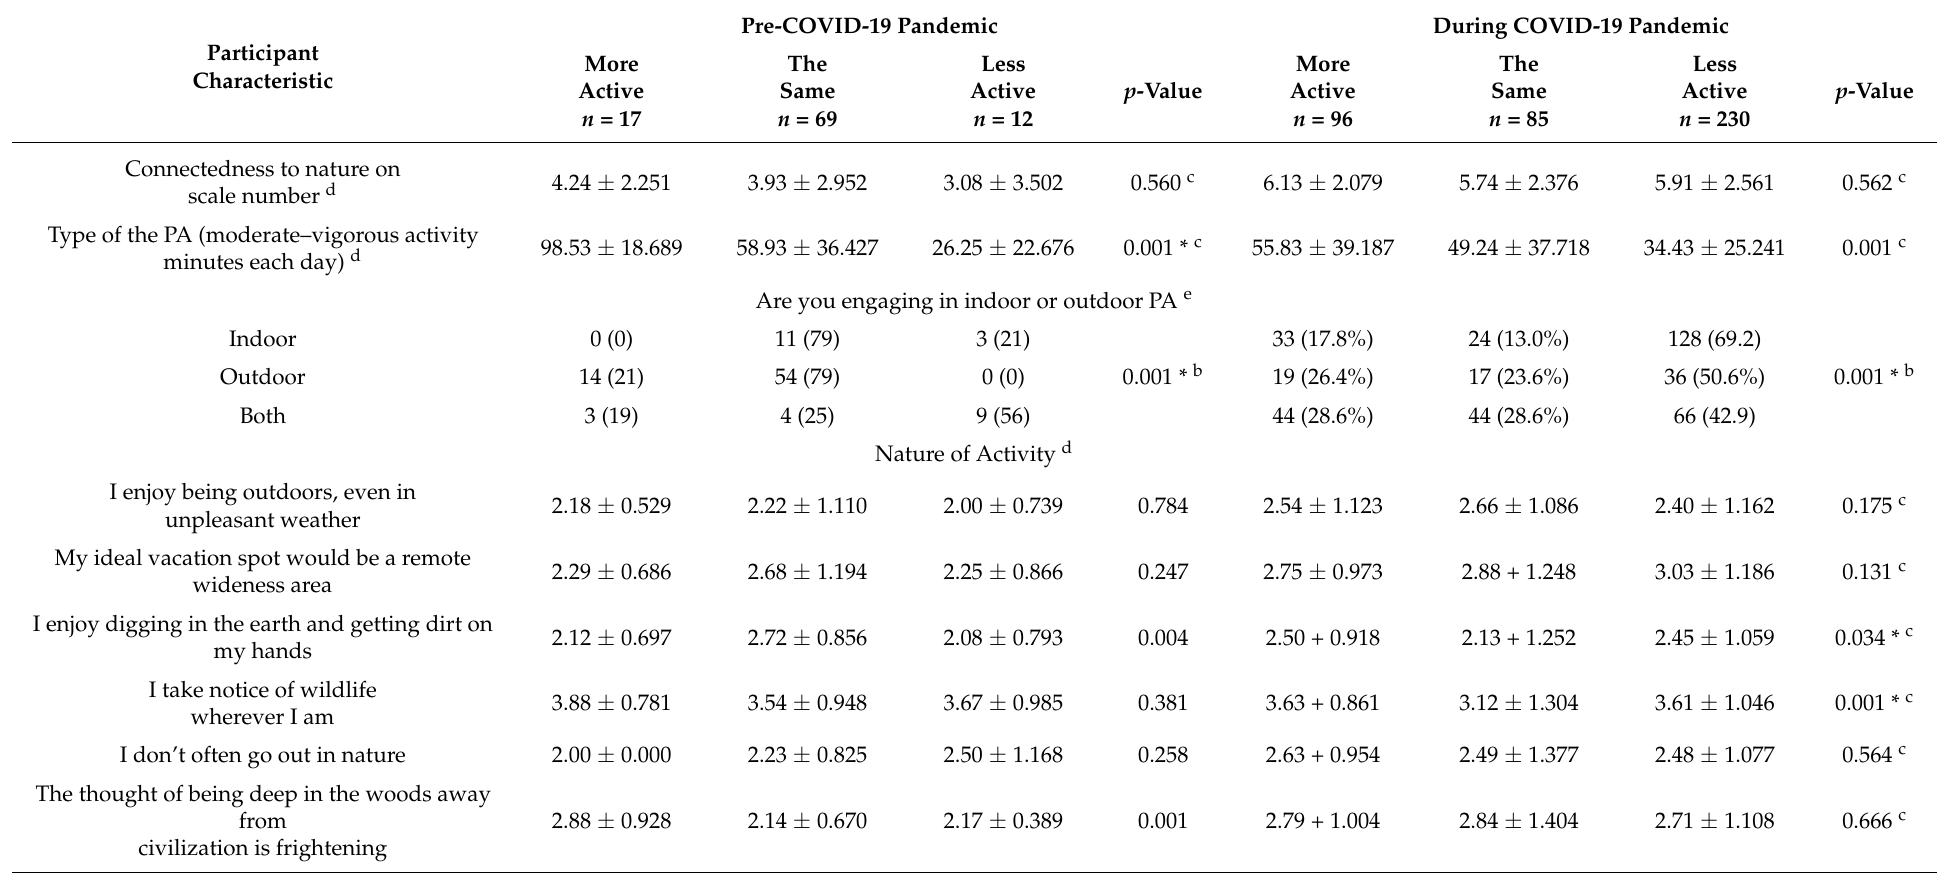
Table 4. The participant’s responses to the nature and place of physical activity engagement during the COVID-19 pandemic.